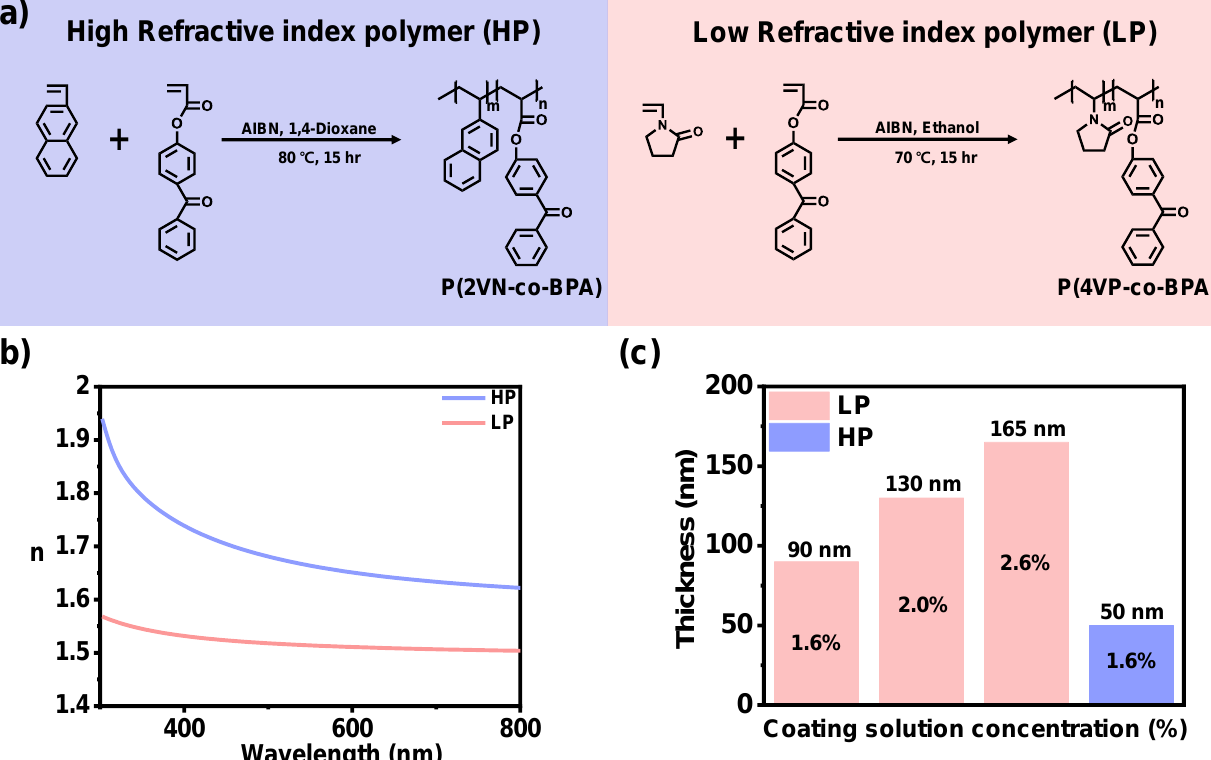
Figure 1. ( a ) Synthesis process of photo-crosslinkable P(2VN-co-BPA) and P(4VP-co-BPA) as high/low refractive index polymers. ( b , c ) Monolayer refractive index and thickness of HP and LP